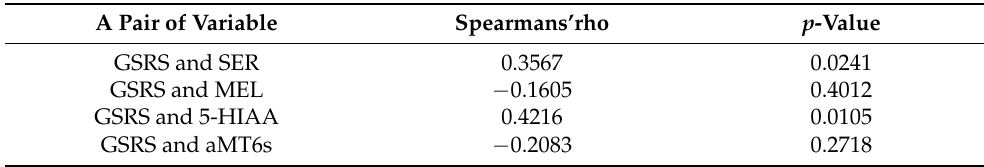
Table 3. Correlation between gastrointestinal symptom rating scale (GSRS) and serum serotonin (SER) and melatonin (MEL) levels, and between GSRS and urinary 5-hydroxyindoleacetic acid (5-HIAA) and 6-sulfatoxymelatinin (aMT6s) excretion, in patients with diarrhea-predominant irritable bowel syndrome.